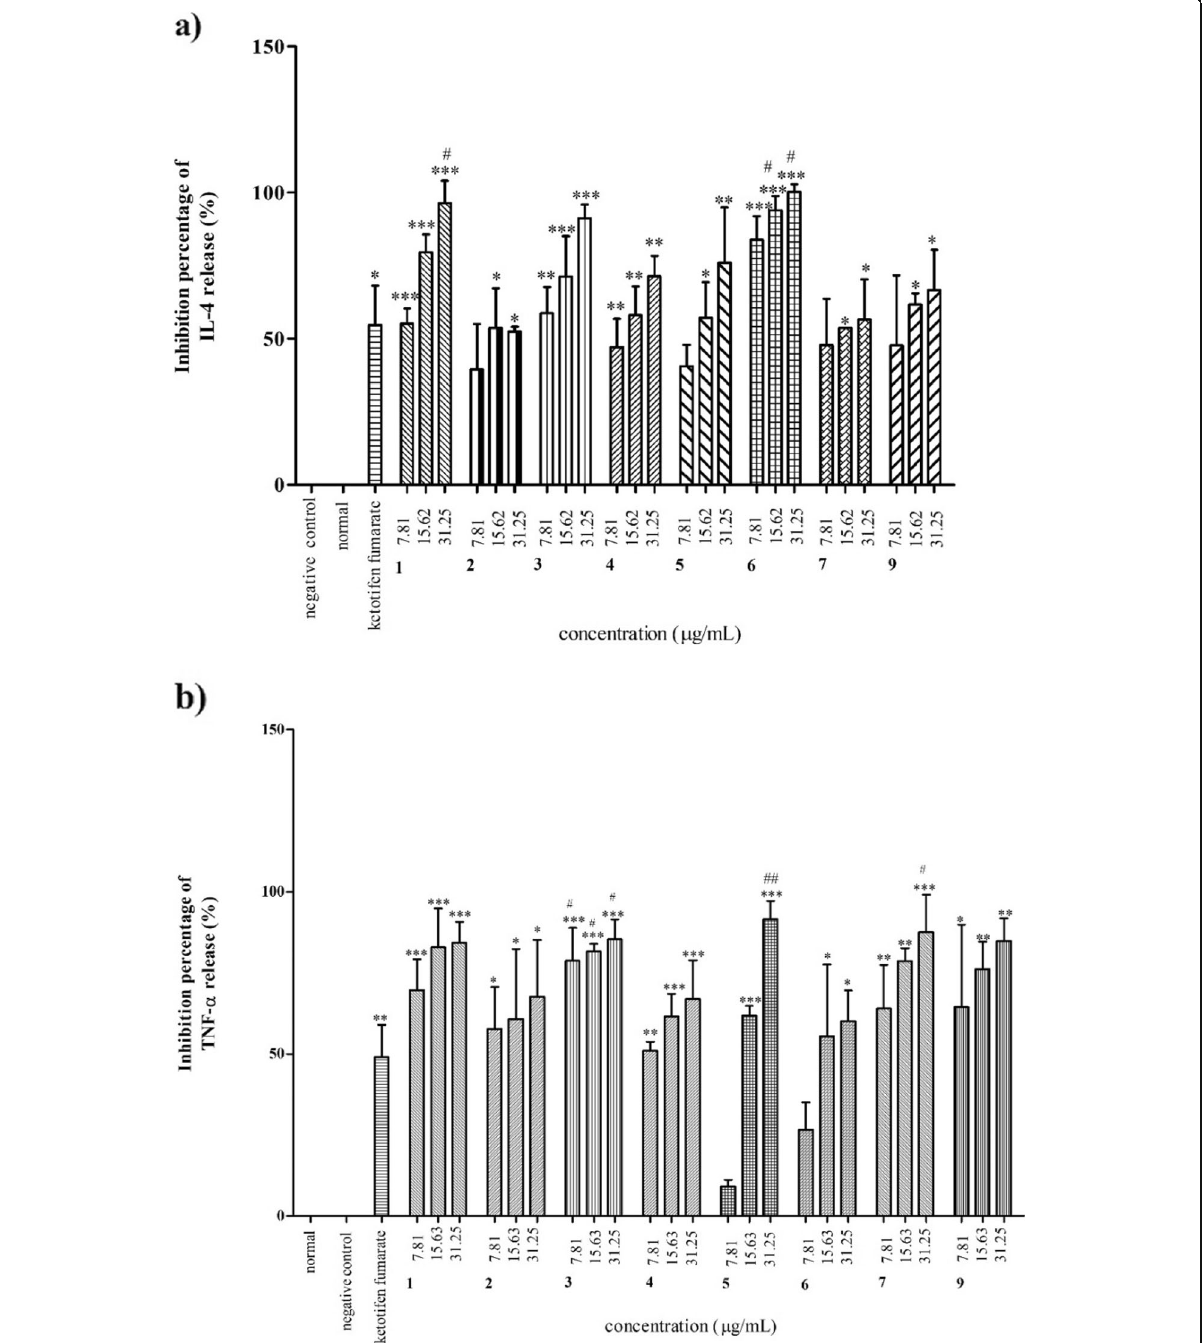
Fig. 6 Percentage inhibition of M. oleifera test compounds on a ) IL-4 and b ) TNF- α releases. Data are presented as mean ± SEM (n = 3) with significant value of *p < 0.05, **p < 0.01, ***p < 0.001 as compared to positive control and and # p < 0.05, ## p < 0.01 as compared to ketotifen fumarate. Ethyl-( E )-undec-6-enoate (1), 3,5,6-trihydroxy-2-(2,3,4,5,6-pentahydroxyphenyl)-4 H -chromen-4-one (2), Quercetin (3), Kaempferol (4), β - sitosterol-3- O -glucoside (5), Oleic acid (6), Glucomoringin (7), the calcium influx from extracellular medium [40, 41]. The to stabilise mast cell from degranulation and inhibit the specific pathway of inhibition was reported to be via the release of IL-4 and TNF- α from IgE-mediated RBL-2H3 Syk pathway that attenuated the ERK activation and hence cells. Quercetin ( 3 ) and kaempferol ( 4 ) have been reported inhibited the release of IL-4 and TNF- α release [42, 43]. In to inhibit mast cells from degranulation by suppressing